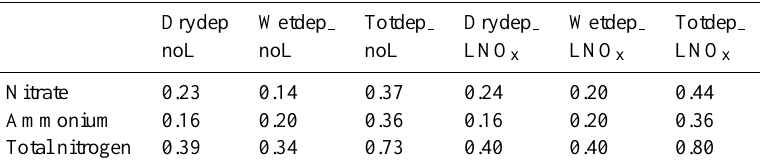
Table 2. Mean dry and wet deposition of nitrate, ammonium, and total nitrogen (N) for June–August 2006 time period from CMAQ simu- lations without (noL) and with (LNO x ) lightning-NO production. Results are obtained by averaging model output over region